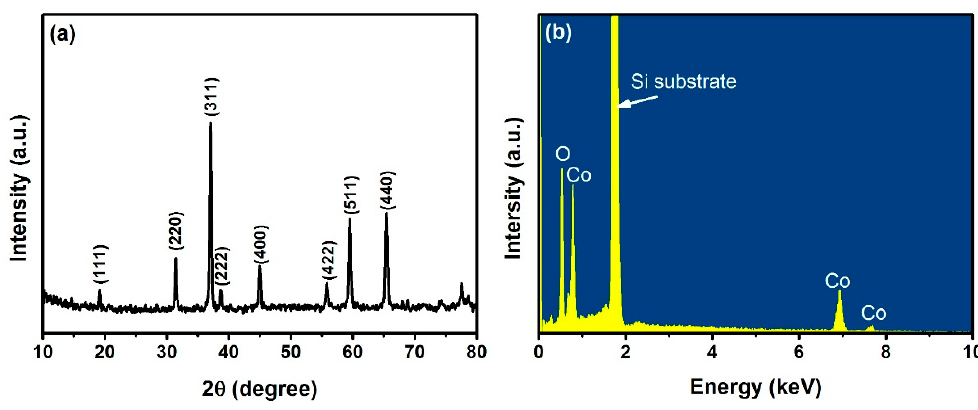
Figure 2. ( a ) XRD patterns and ( b ) energy-dispersive X-ray (EDX) spectrum of the obtained Co 3 O 4 .